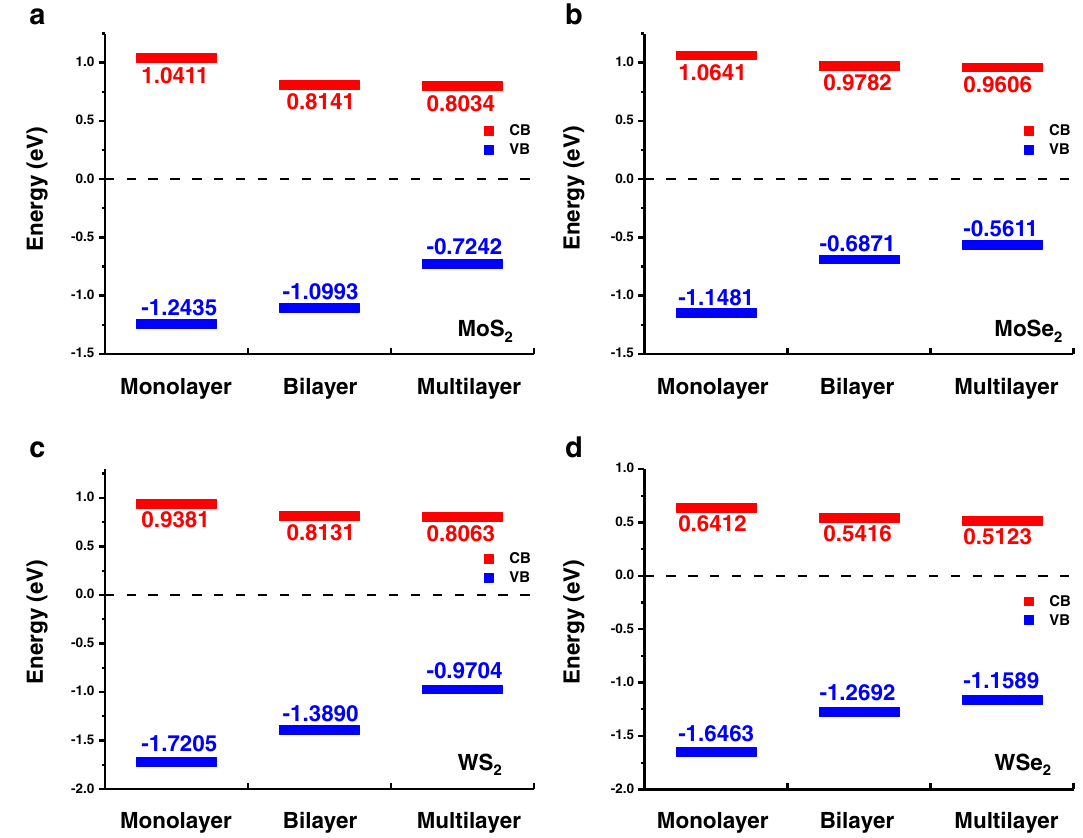
Fig.3|LEFMmeasurementresultsofseveralTMDCsamples. Bandedgesof a MoS 2 , b MoSe 2 , c WS 2 ,and d WSe 2 revealedbytheLEFMtechnique.Theconductionband (CB) edges are marked in red and the valance band (VB) edges are in blue.